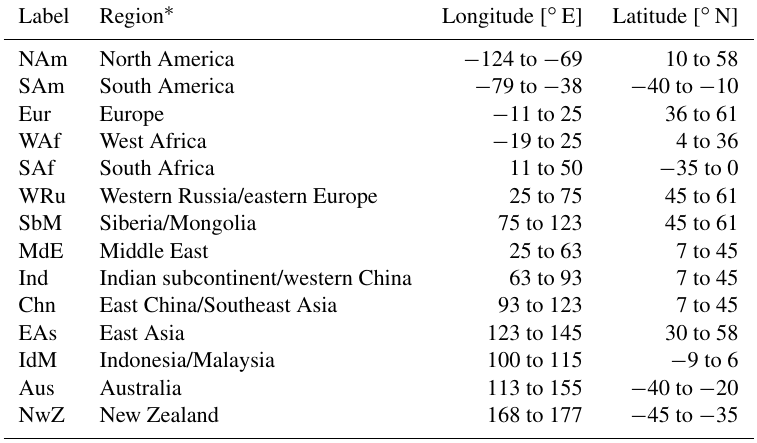
Table 2. Definition of regions used for the regional statistics shown in Table 3 and for regional figures shown in the Supplement. Label